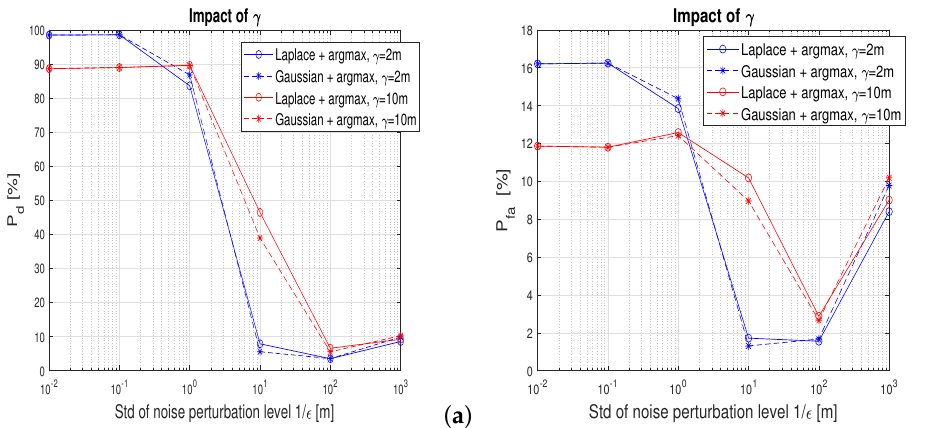
Figure 11. Impact of the proximity threshold on ( a ) detection P d and ( b ) false-alarm rates P fa .